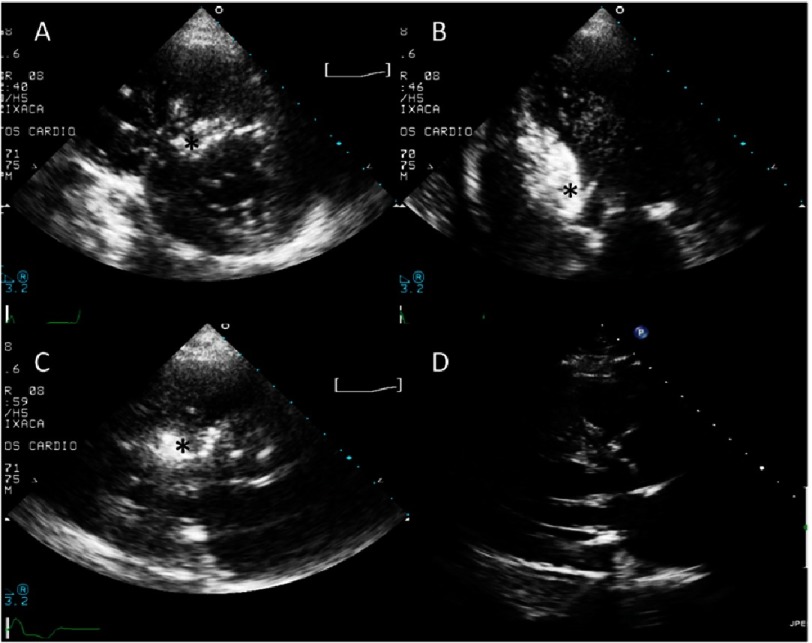
Contrast echocardiography.Multiple projections: A. Paraesternal short axis. B. Apical four-chamber. C. Paraesternal long axis. * Opacification of the targeted area of the septum. D. Paraesternal long axis after septal ablation.